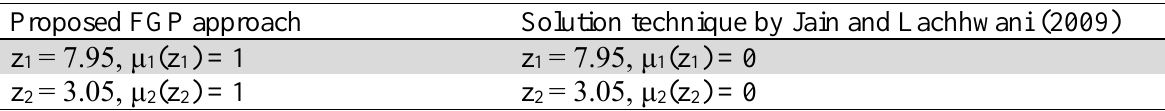
Comparison of membership function values for example 2 Proposed FGP